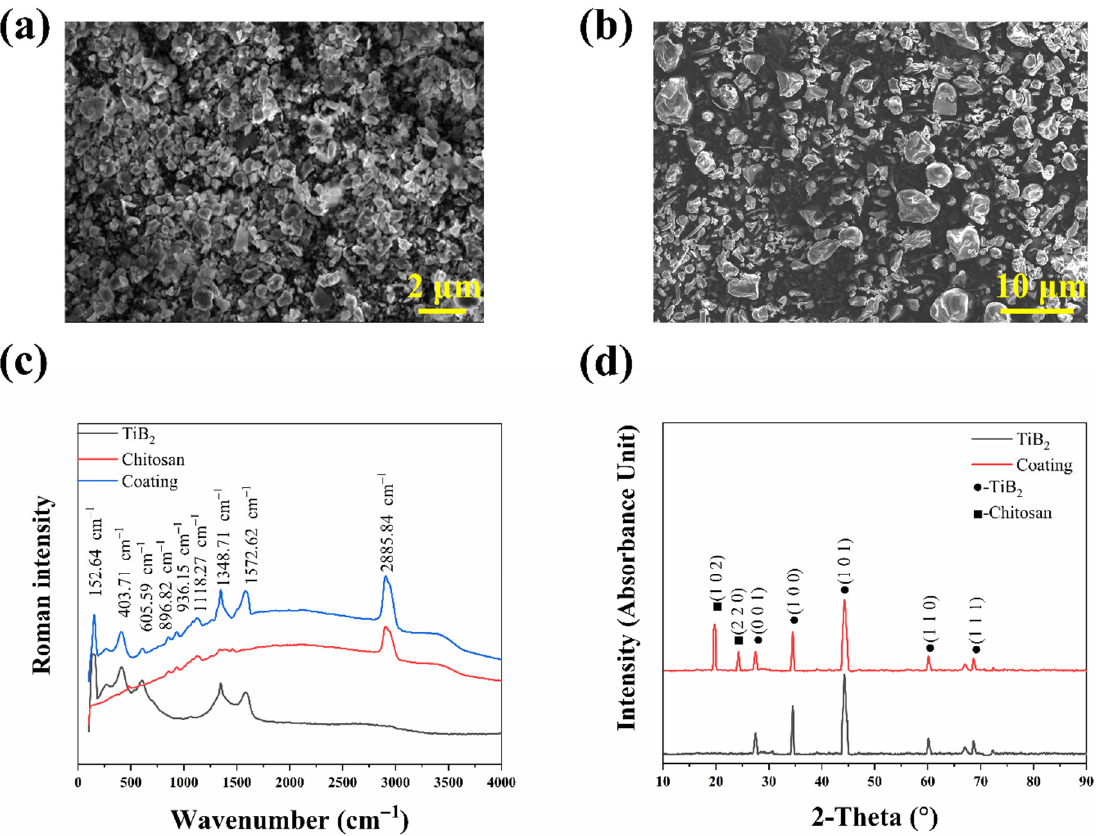
Figure 2. ( a ) Microstructure of the TiB 2 particles, ( b ) Microstructure of Chitosan, ( c ) Raman spec- troscopy of powders and coating, ( d ) The XRD pattern of the TiB 2 and coating.